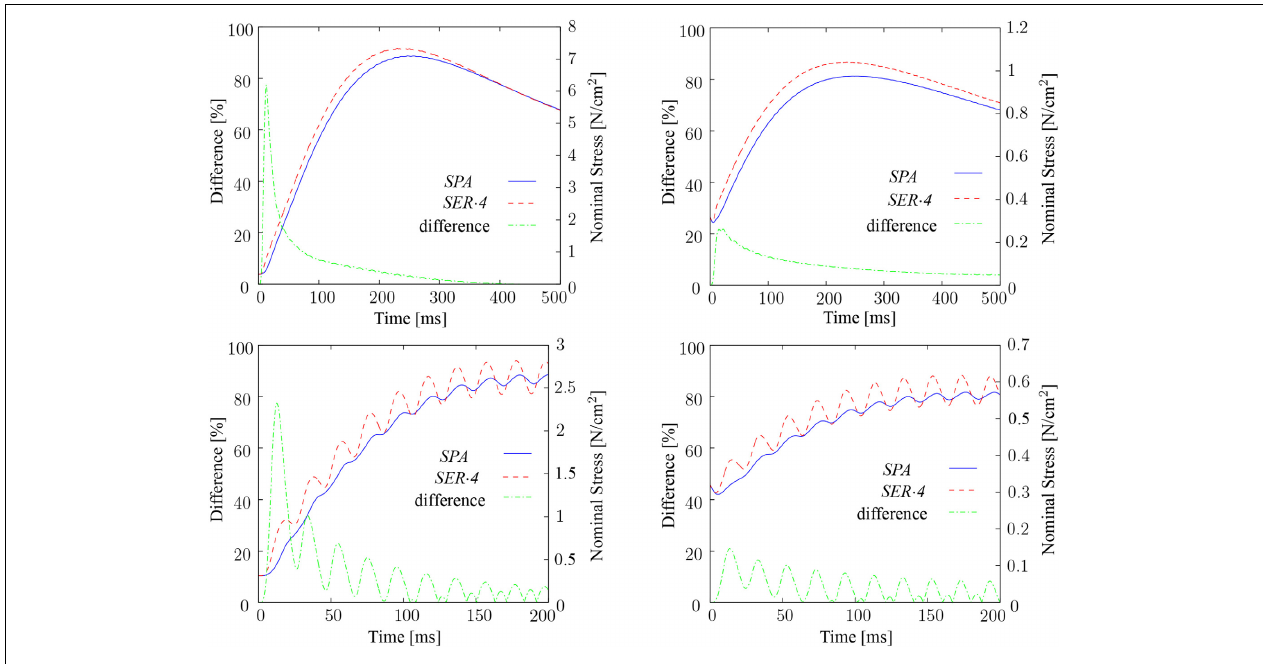
f s = 50Hz (bottom row) in fixed-end (left column) and shortening contractions at v = 0 . 1 v max (right column), and their differences in